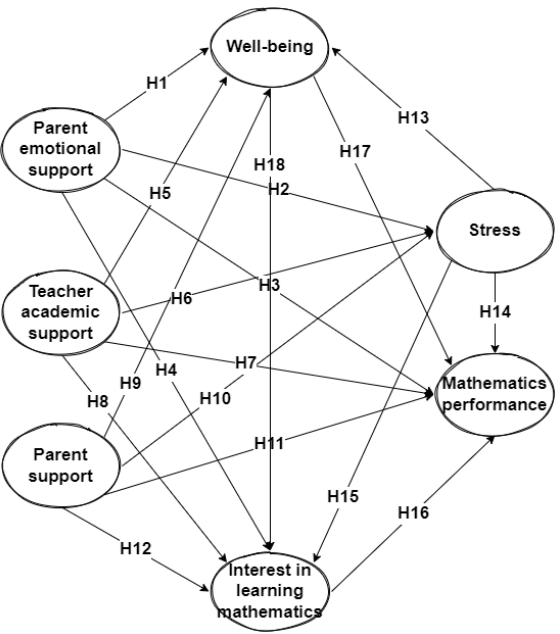
Figure 1. Initial hypotheses that are expected to affect students′ mathematics achievement.